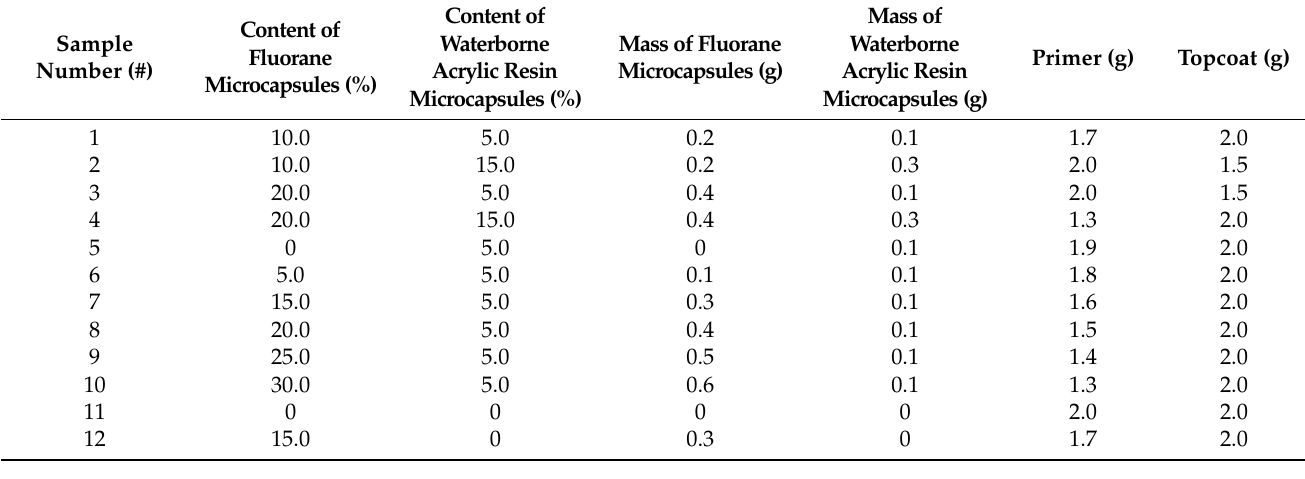
Table 2. Ingredient of thermochromic and self-healing waterborne